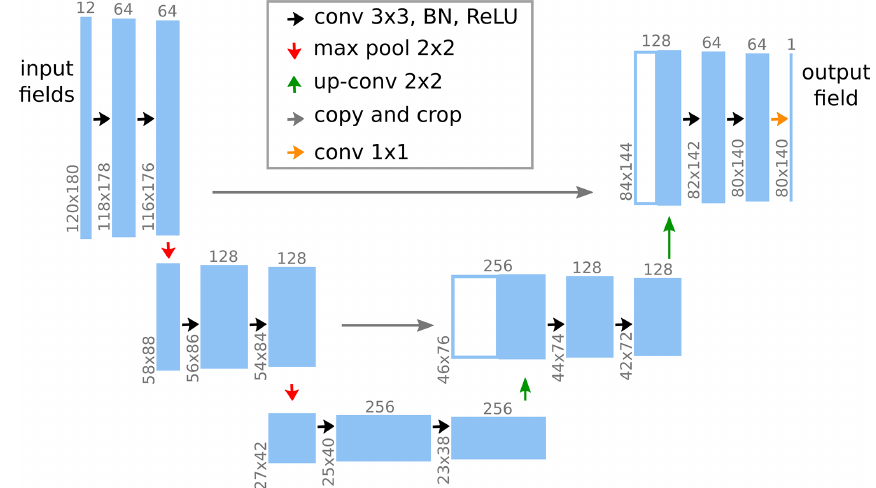
Figure 4. Model architecture in the example of soil-moisture–precipitation coupling. The leftmost blue box represents the input to the model, which consists of 12 variables (including soil moisture) at the 120 × 180 input pixels (see Fig. 3). This input is passed through multiple sequential modules represented by the arrows. Each module performs simple mathematical operations on its respective inputs and produces an output that is fed to the next module. This output is represented by the next blue box and, in general, differs in shape from the input, as indicated by the grey upright and rotated numbers. For details on the mathematical operations we refer to Ronneberger et al. (2015). The rightmost blue box represents the output of the model, which consists of the precipitation prediction at the 80 × 140 target pixels. The combination of multiple simple modules allows the model to represent complex